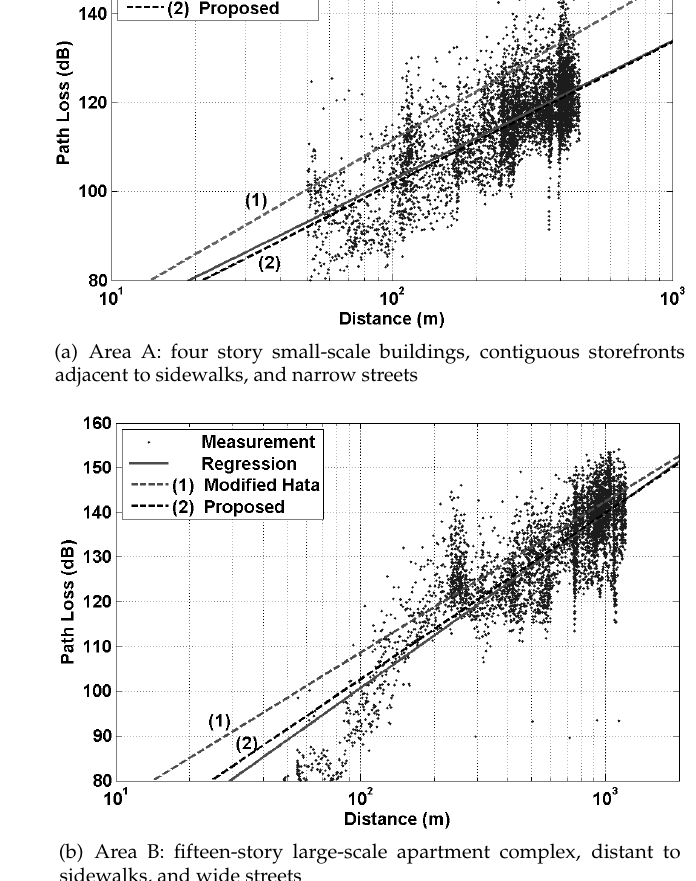
Figure 1. Measured path loss and linear-log distance models presented in